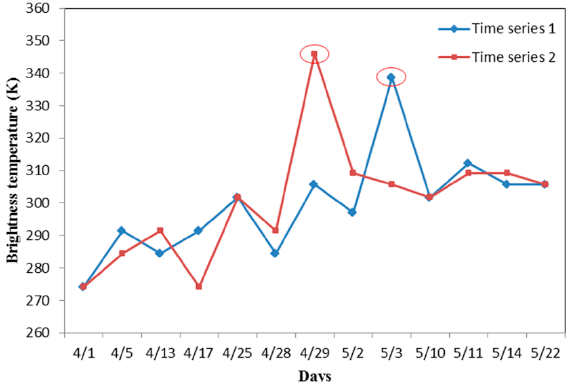
Figure 10. Time series of fire pixels. The red marks represent fire points.